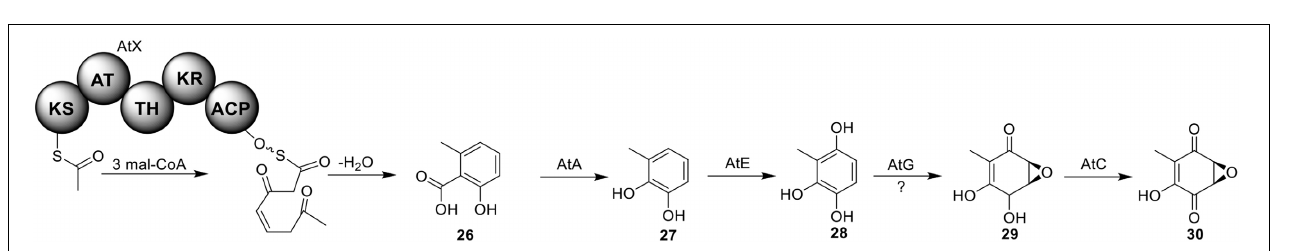
IDENTIFICATION OF THE PRODUCTS OF SIX NR-PKS GENES IN